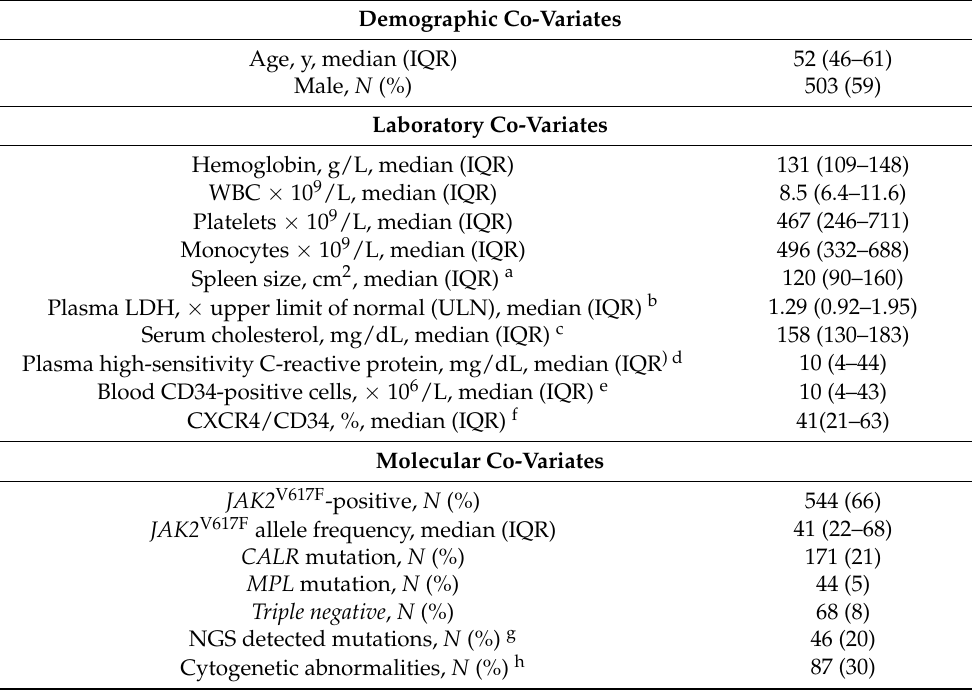
Table 1. Baseline co-variates ( N =